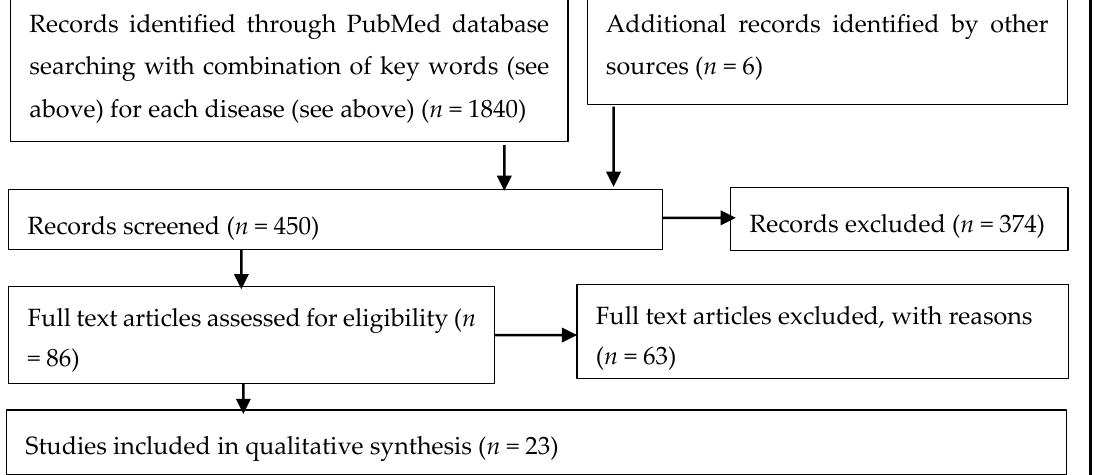
Records identified through PubMed database